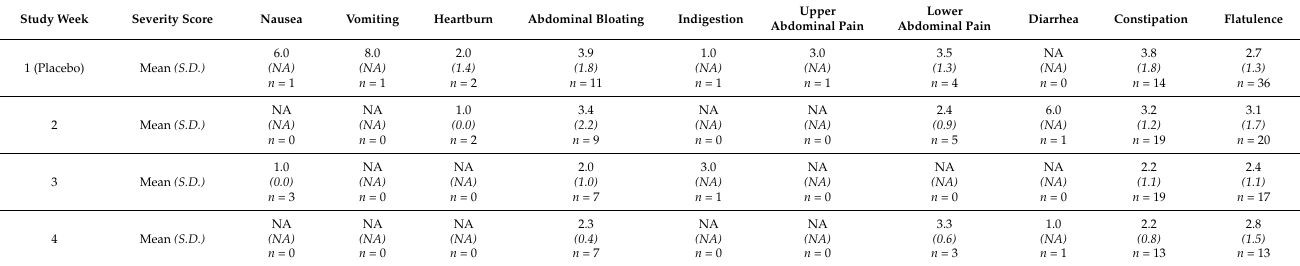
Table 7. Summary of GI symptom severity ratings (mean and S.D.) in healthy adults given B. subtilis